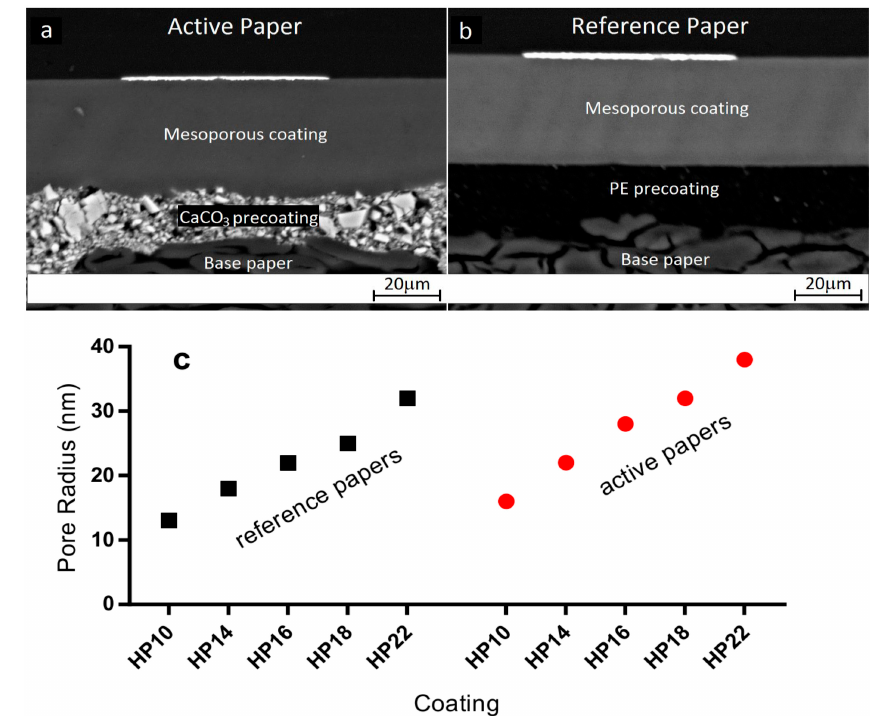
Figure 1. Active papers and reference papers. The construction of the ( a ) active paper series with porous precoating and the ( b ) reference paper series with nonporous precoating (scanning electron microscopy cross-sections). The top white layers are AgNP films. Only the upper part of the base paper is visible. ( c ) Dominant coating pore radius of each paper (mercury porosimetry).